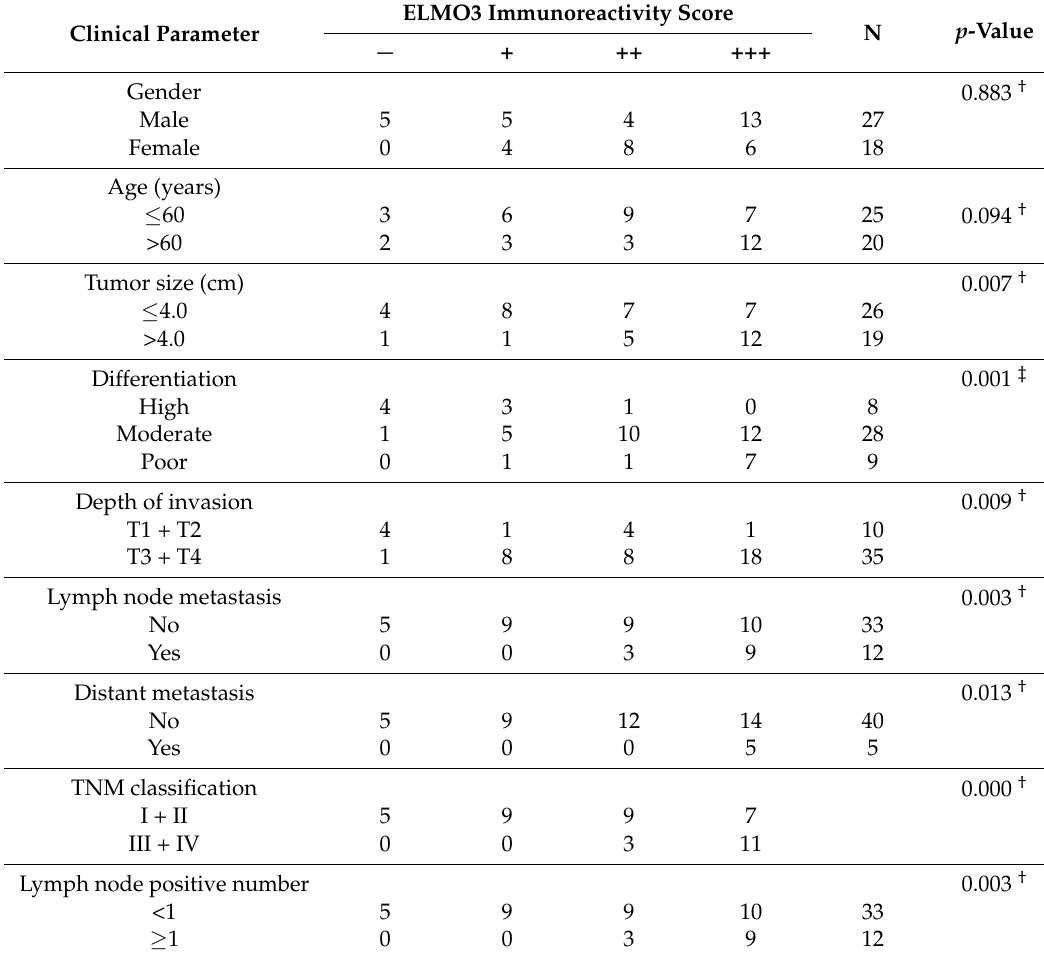
Table 2. Association analysis of ELMO3 expression with clinicopathological parameters of CRC